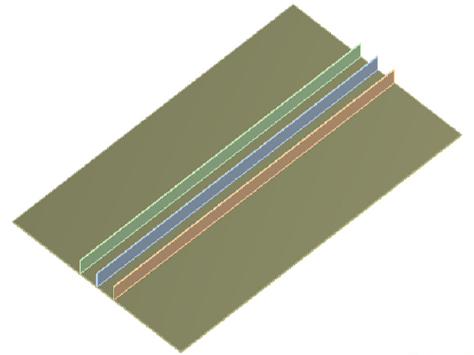
Figure 2. Illustration of the reinforcing ribs along the long side.